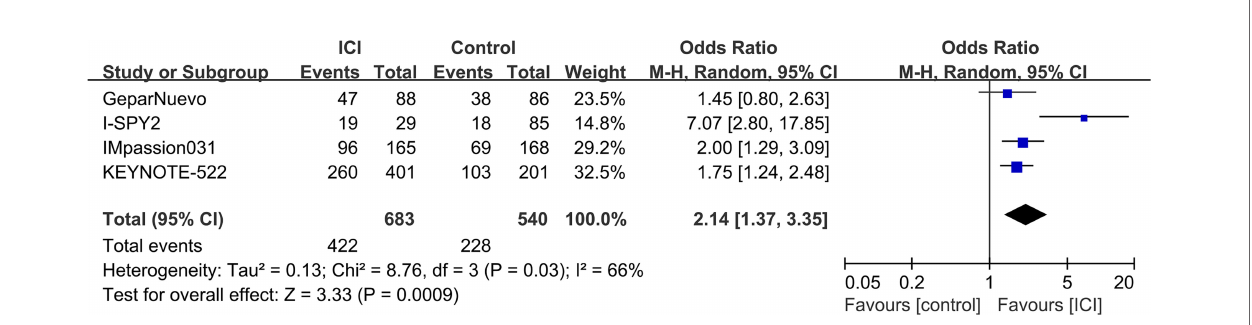
FIGURE 2 | Forest plots of meta-analyses of pathological complete response (pCR). Immune checkpoint inhibitor (ICI)-containing neoadjuvant therapy compared with ICI-free neoadjuvant therapy for triple-negative breast cancer